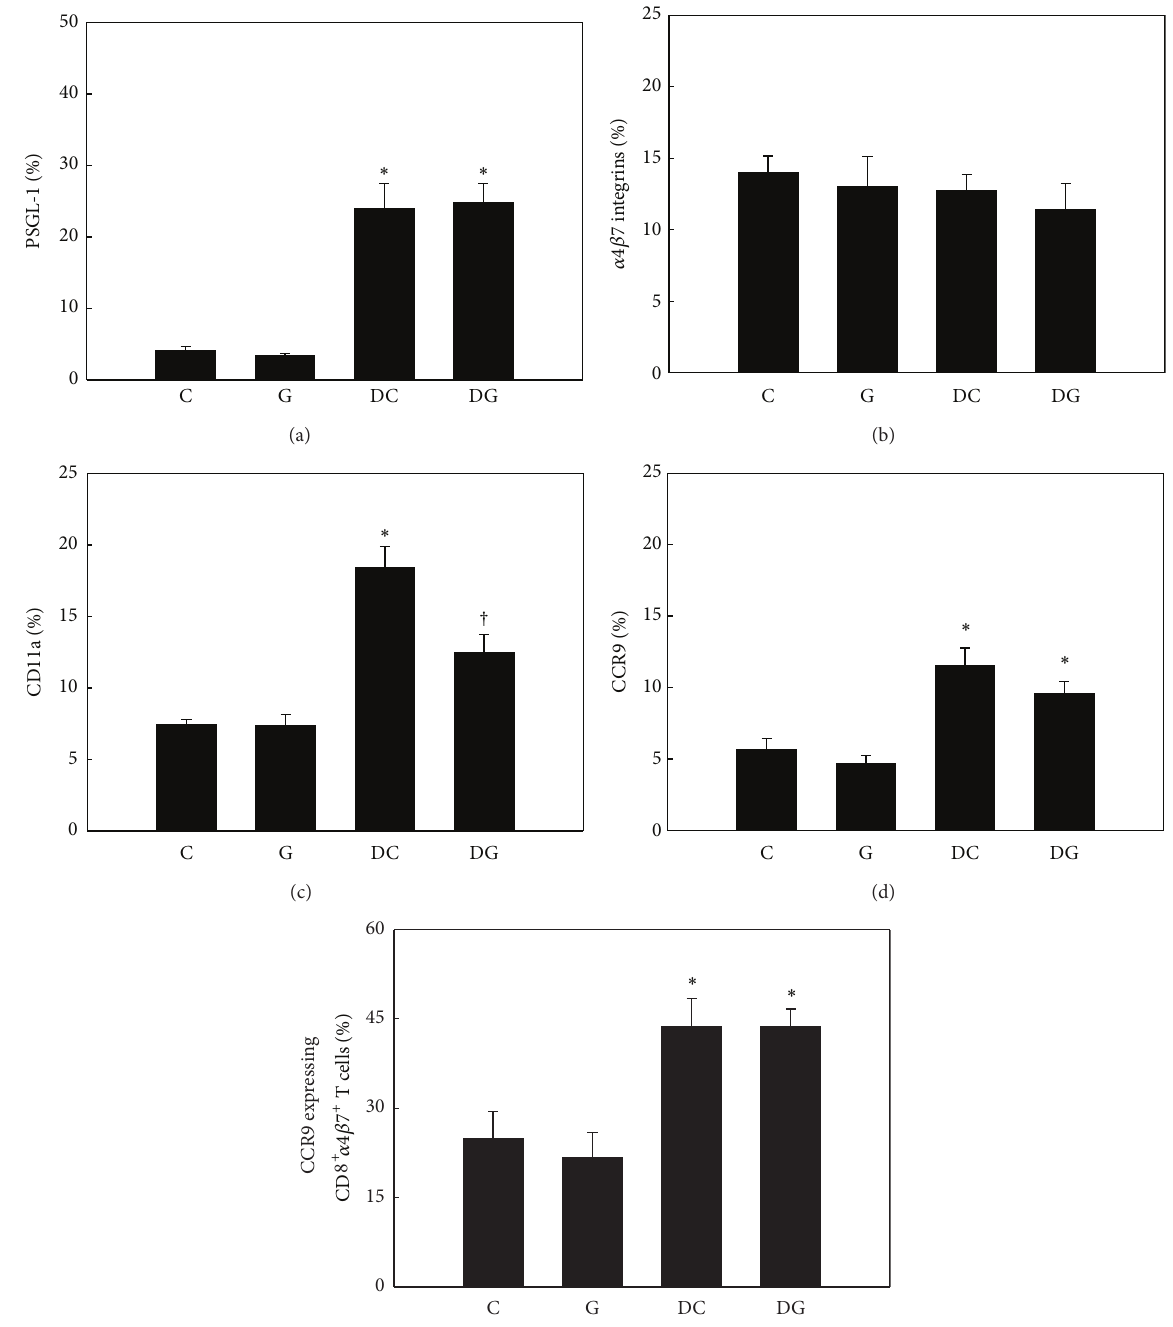
Figure 7: Percentage of adhesion molecule- and chemokine receptor-expressing cytotoxic T (Tc) cells in mesenteric lymph nodes (MLNs). CD8-positive MLN lymphocytes were gated to analyze expressions of PSGL-1, 𝛼4𝛽7 integrins, CD11a, and CCR9 by flow cytometry ((a)–(d)). (e) Expression of CCR9 by CD8 and 𝛼4𝛽7 integrin double-positive MLN lymphocytes. Values are shown as the mean ± SEM. ∗ Significantly different from the C group ( 𝑃 < 0.05 ). † Significantly different from the DC group ( 𝑃 < 0.05 ).